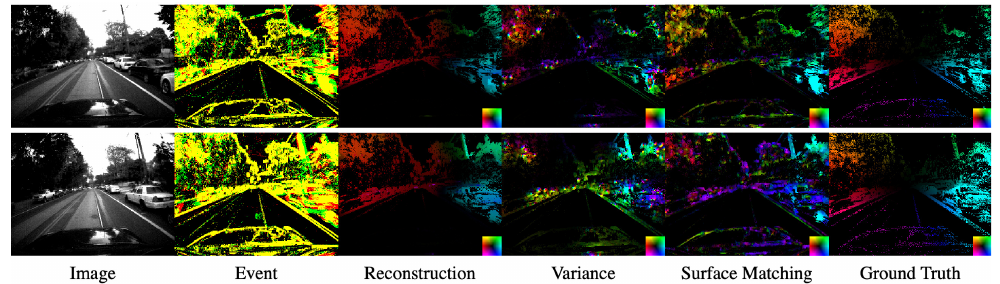
Figure 9. Qualitative results when shaking by the ground in an outdoor scene.